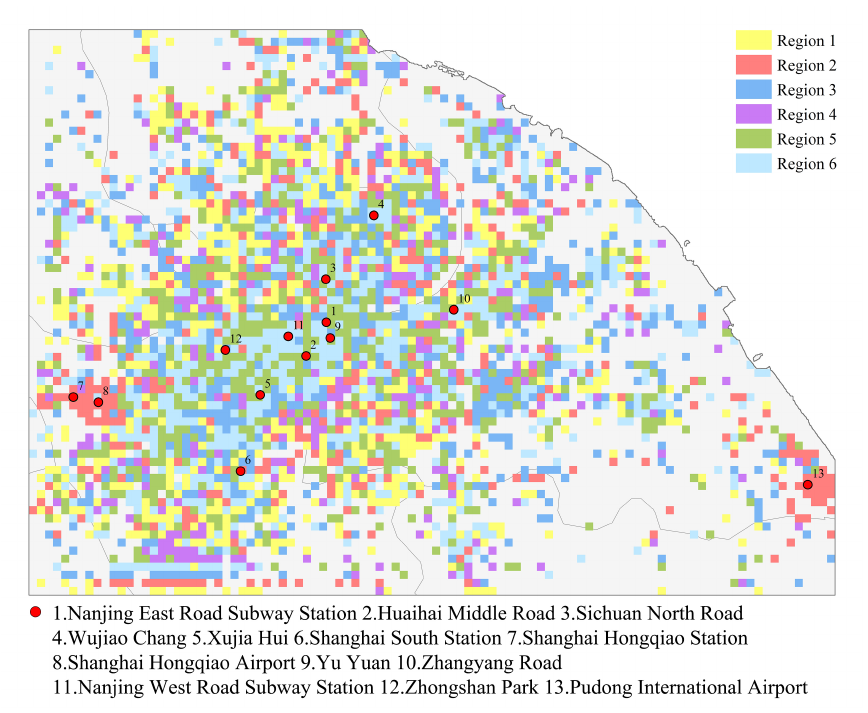
Figure 7. Geographical distribution of functional regions detected by the low-rank approximation (LRA) Method.